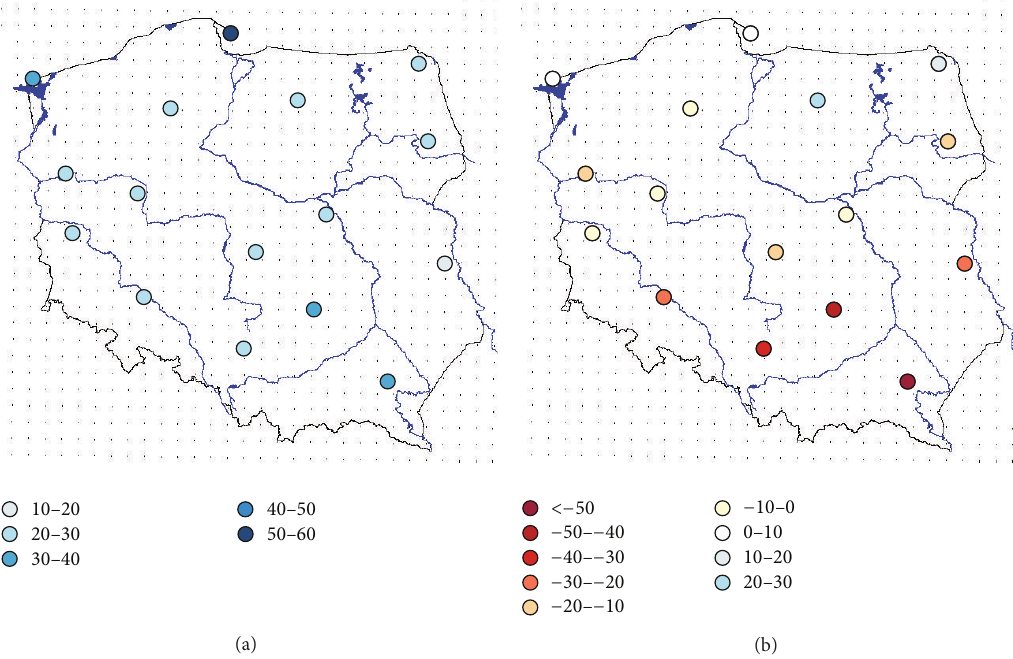
Figure 5: The changes of winter (a) and summer (b) precipitation [in mm] in the future (2061–2090) compared to the control period 1961– 1990, based on the MPI-M-REMO model. Table 6: The changes of the monthly and annual precipitation [in mm] in the future (2061–2090) compared to the control period 1961–1990— average value from five models.